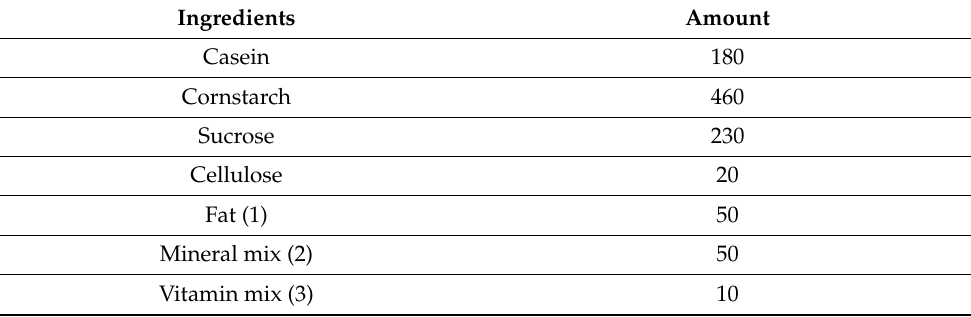
Table 1. Composition of the diets (g/kg diet). 1: For a detailed composition of fatty acids, see Table 2. Composition (g/kg): sucrose, 110.7; CaCO 3 , 240; K 2 HPO 4 , 215; CaHPO 4 , 215; MgSO 4 · 7H 2 O, 100; NaCl, 60; MgO, 40; FeSO 4 · 7H 2 O, 8; ZnSO 4 · 7H 2 O, 7; MnSO 4 · H 2 O. 2: CuSO 4 · 5H 2 O, 1; Na 2 SiO 7 · 3H 2